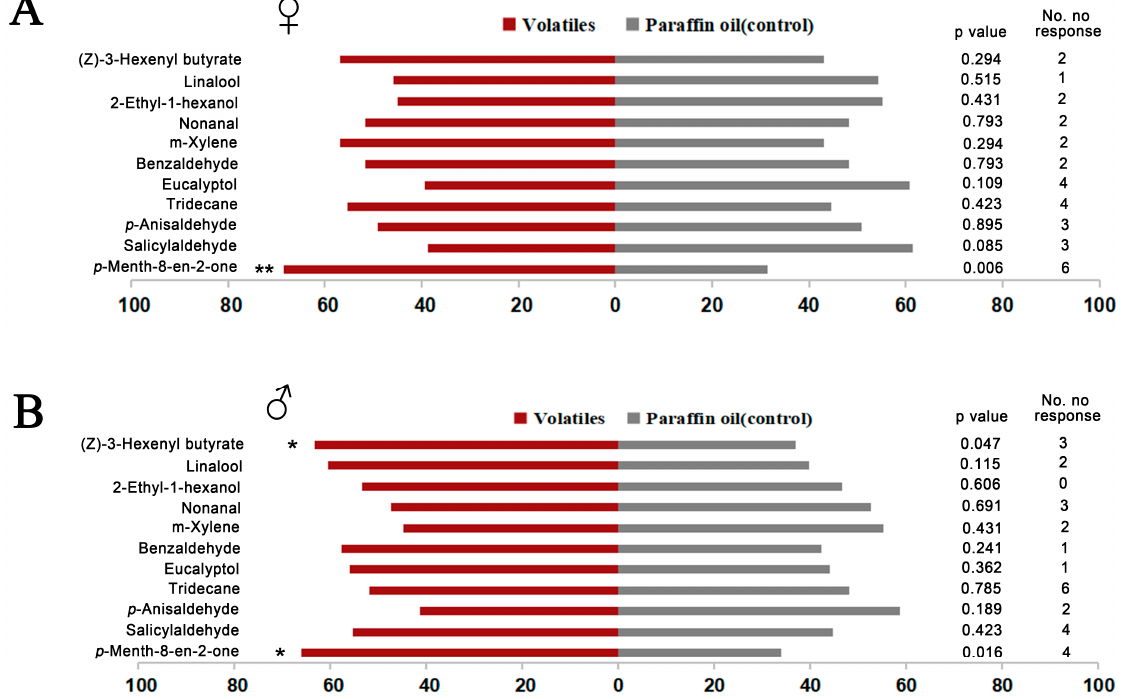
Figure 5. Responses of adult O. loti to 11 volatiles in a Y-tube olfactometer. In the assays, newly emerged 60 female or male adults, of 3 – 5 days of age, were used for testing, and 11 ligands with high binding affinities to O.lotOBP6 based on fluorescence binding assays were used in the test. Results were analyzed by the chi-square test using IBM SPSS 22. ( A ) Responses of female adult O. loti . ( B ) Responses of male adult O. loti . Asterisks indicate significant differences within a choice test (* p < 0.05; ** p < 0.01).